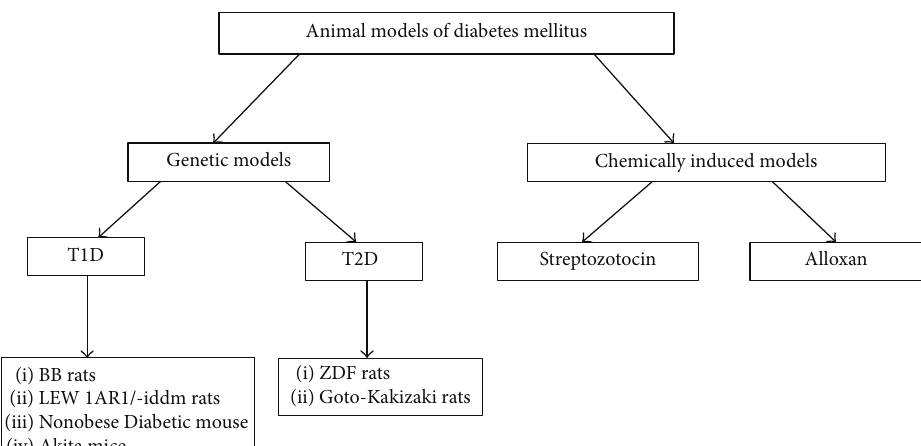
Figure 1: Summary of animal models of diabetes